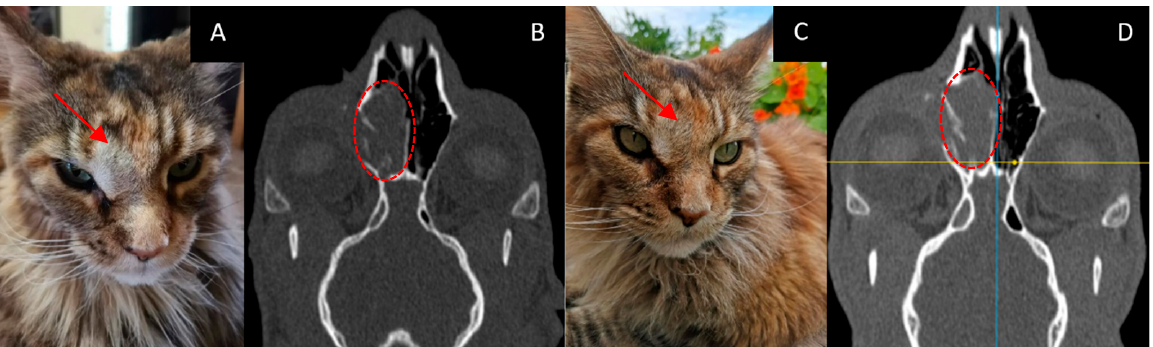
Figure 1. Female cat “Ayuta” (11 years old) with highly differentiated adenocarcinoma in the right nasopharyngeal area, leading to worsening of nasal breathing and nasal discharge. Tumor appearance (( A ), arrow) and head CT (( B ), dashed circle) before irradiation, and tumor appearance (( C ), arrow) and head CT (( D ), dashed circle) 3 months after GdNCT. No significant changes compared to the pretreatment visualization were revealed.